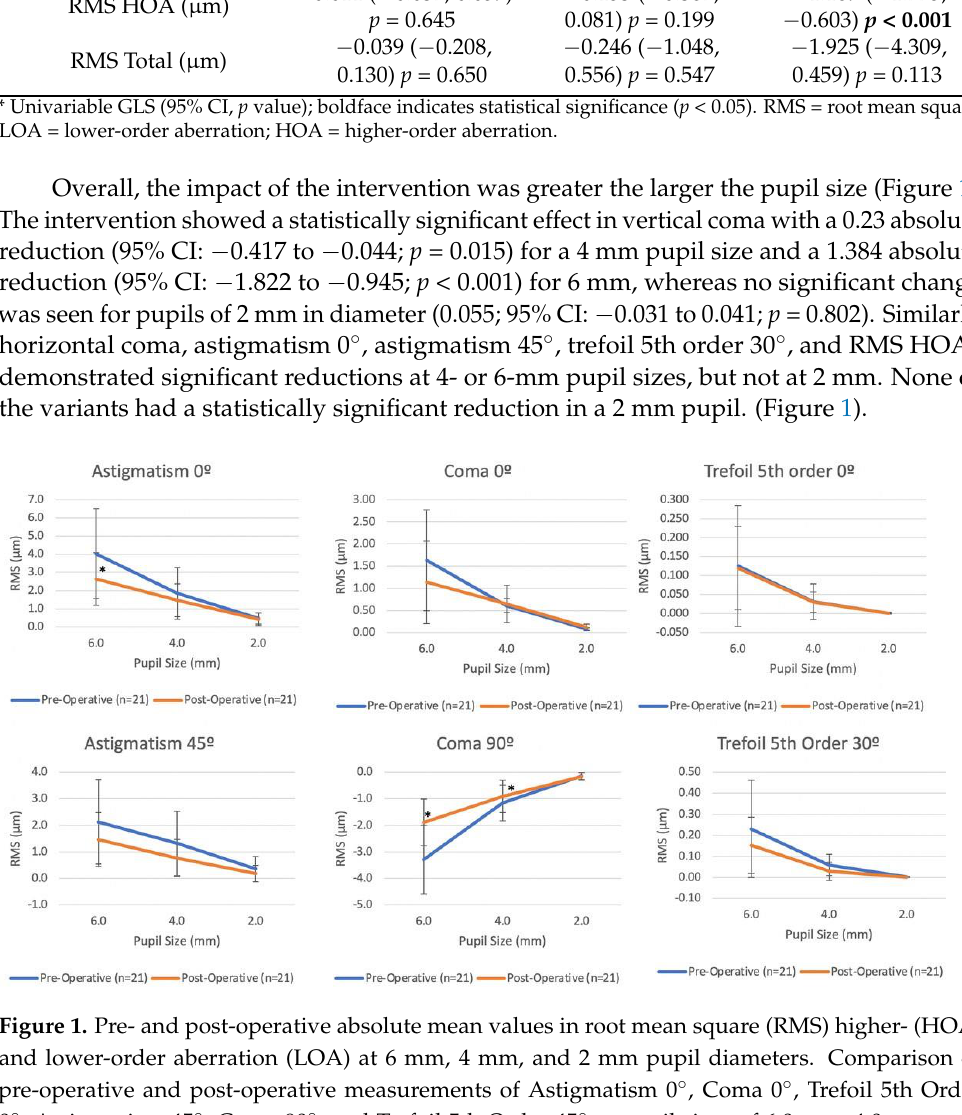
Figure 1. Pre- and post-operative absolute mean values in root mean square (RMS) higher- (HOA) and lower-order aberration (LOA) at 6 mm, 4 mm, and 2 mm pupil diameters. Comparison of pre-operative and post-operative measurements of Astigmatism 0 ◦ , Coma 0 ◦ , Trefoil 5th Order 0 ◦ , Astigmatism 45 ◦ , Coma 90 ◦ , and Trefoil 5th Order 45 ◦ at pupil sizes of 6.0 mm, 4.0 mm, and 2.0 mm. Error bars indicate standard deviation. * Results were found to be statistically significant p < 0.05. Statistical analysis was obtained using generalized least squares linear models comparing pre-operative and post-operative measurements at each pupil